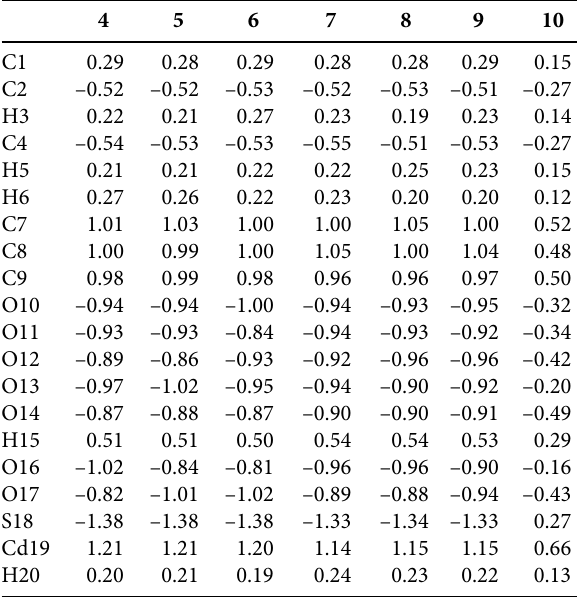
Table 5. NBO charges in a.u. for systems 4-10.